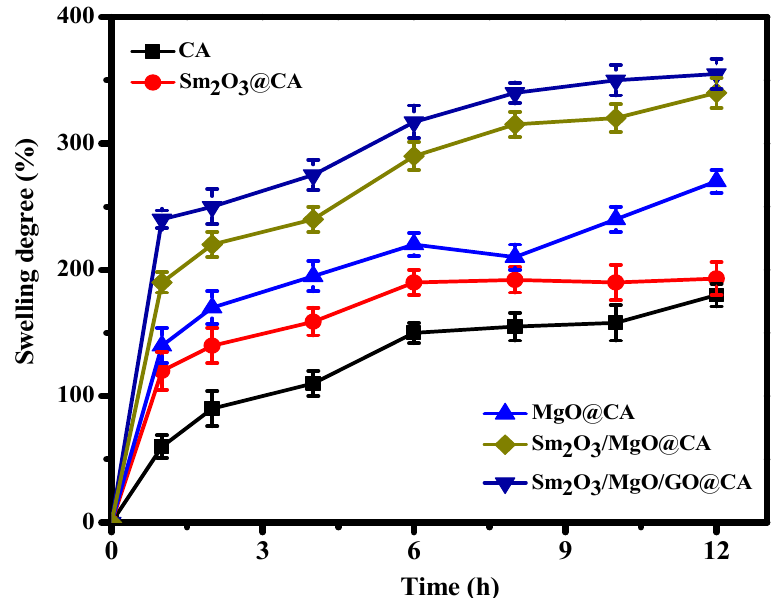
Figure 6. Swallowability degree of CA cast films containing different dosages of Sm 2 O 3 and MgO nanoparticles.